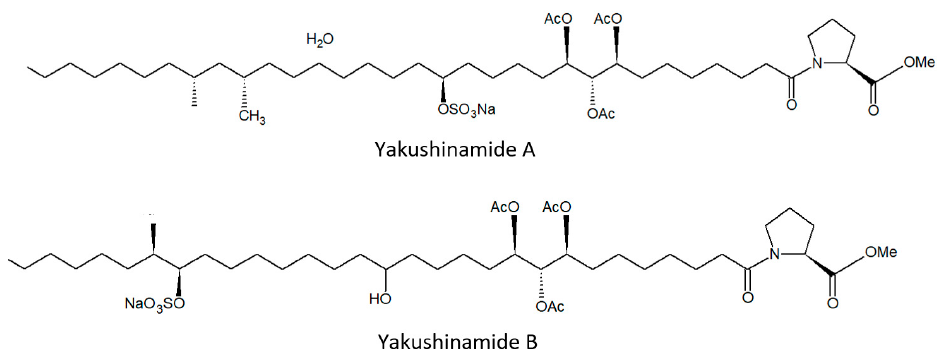
Figure 9. Structures of yakushinamide ( A ) and ( B ).